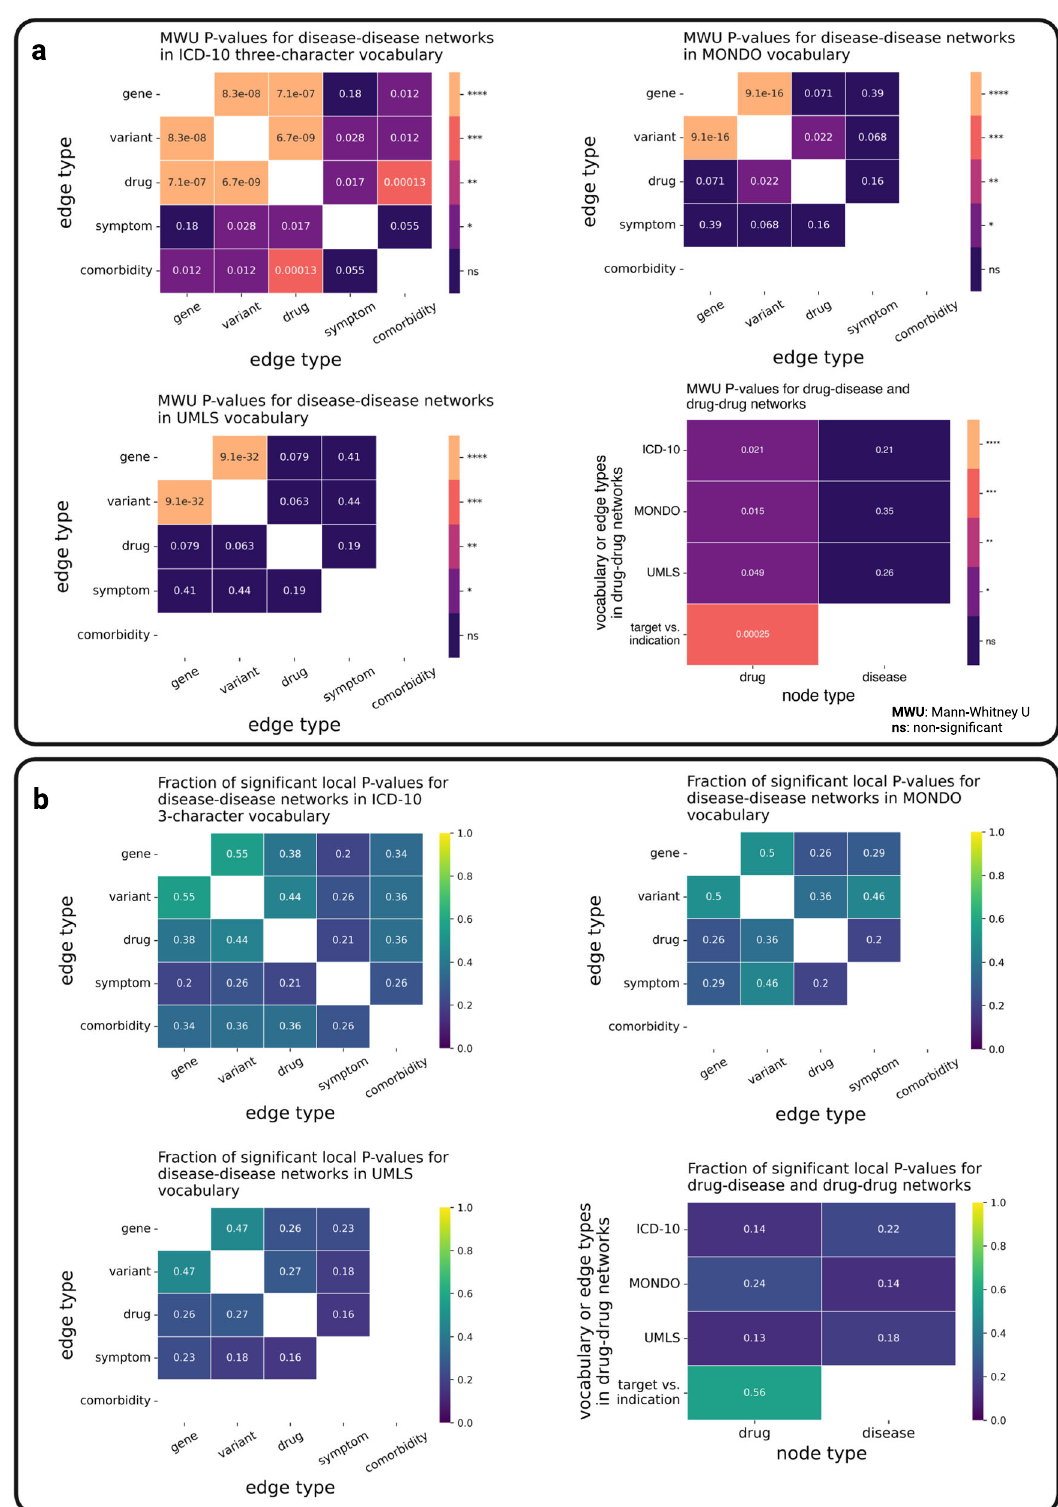
Fig. 6 | Local-scale analyses: MWU P -values and local empirical P -values. a Overview of MWU P -values (one-sided, unadjusted) computed from local GEDs with levels of signi fi cance. b Fraction of signi fi cant local empirical P -values (one-